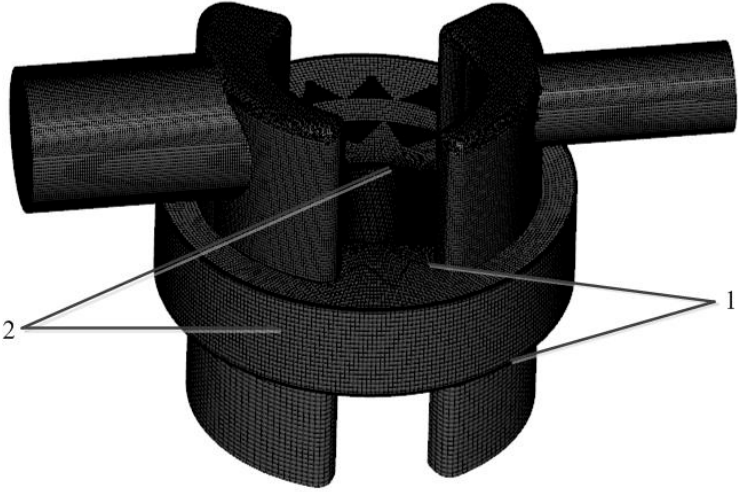
Figure 11. Flow channel grid model of the straight line conjugate internal meshing gear pump: 1–axial clearance; 2–radial clearance.